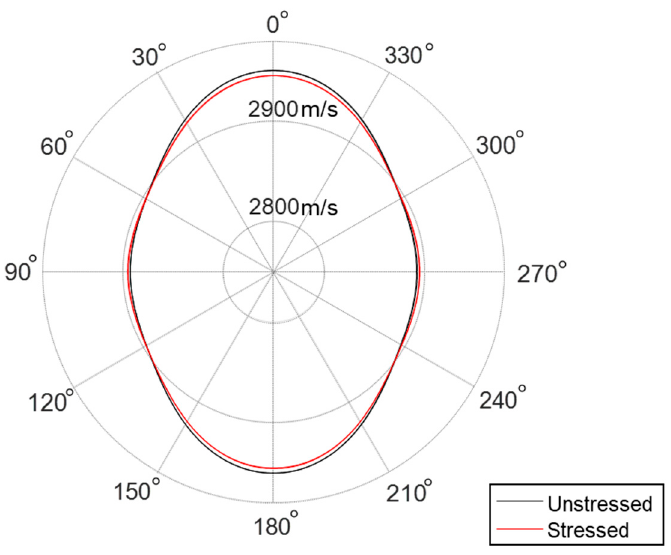
Figure 3. Surface wave velocity according to the propagation direction for unstressed and stressed states in an anisotropic material.